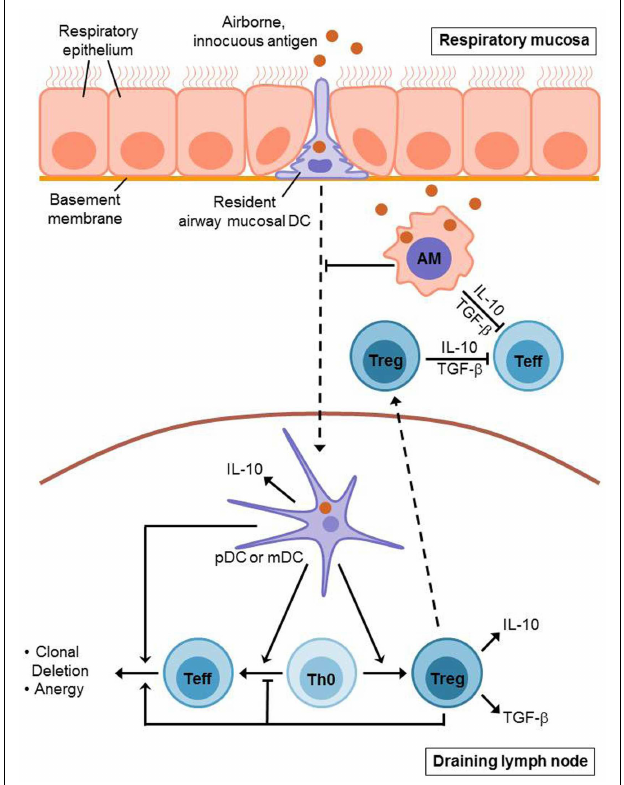
FIGURE 1 | Induction ofT cell mediated airway tolerance. Innocuous antigen reaches the respiratory epithelium where it is recognized by resident airway mucosal dendritic cells (AMDCs).These DCs extend long protrusions which enable them to sample the antigen directly from the airway lumen. Afterwards, the AMDCs (including pDCs and mDCs) migrate to the draining lymph nodes presenting the sampled antigen. Antigen presentation by mDCs leads to an initial activation and expansion of antigen-specificT cells. However, this is followed by inactivation and deletion of these effectorT (Teff) cells and the generation of regulatoryT (Treg) cells.This process also involves pDCs which contribute to the induction ofTreg cells as well.Treg cells mediate clonal deletion and anergy ofTeff cells in the draining lymph nodes as well as in the respiratory mucosa where they are recruited to during tolerance induction. Alveolar macrophages (AMs) contribute to airway tolerance via phagocytosis and sequestration of incoming antigens. Moreover, they directly inhibitT cell responses and seem to suppress dendritic cell migration as well as antigen presentation.Treg cells, AMs, and pulmonary DCs each secrete immunosuppressive cytokines such as IL-10 andTGF- β